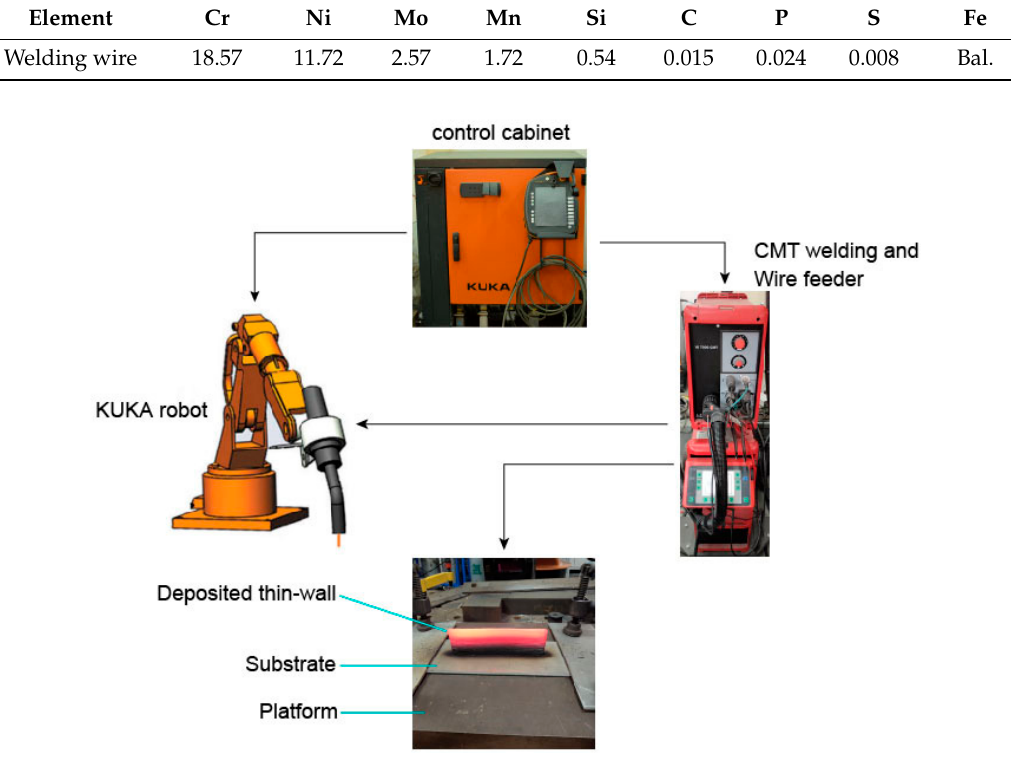
Figure 1. Cold metal transfer plus pulse (CMT + P) process additive manufacturing system.